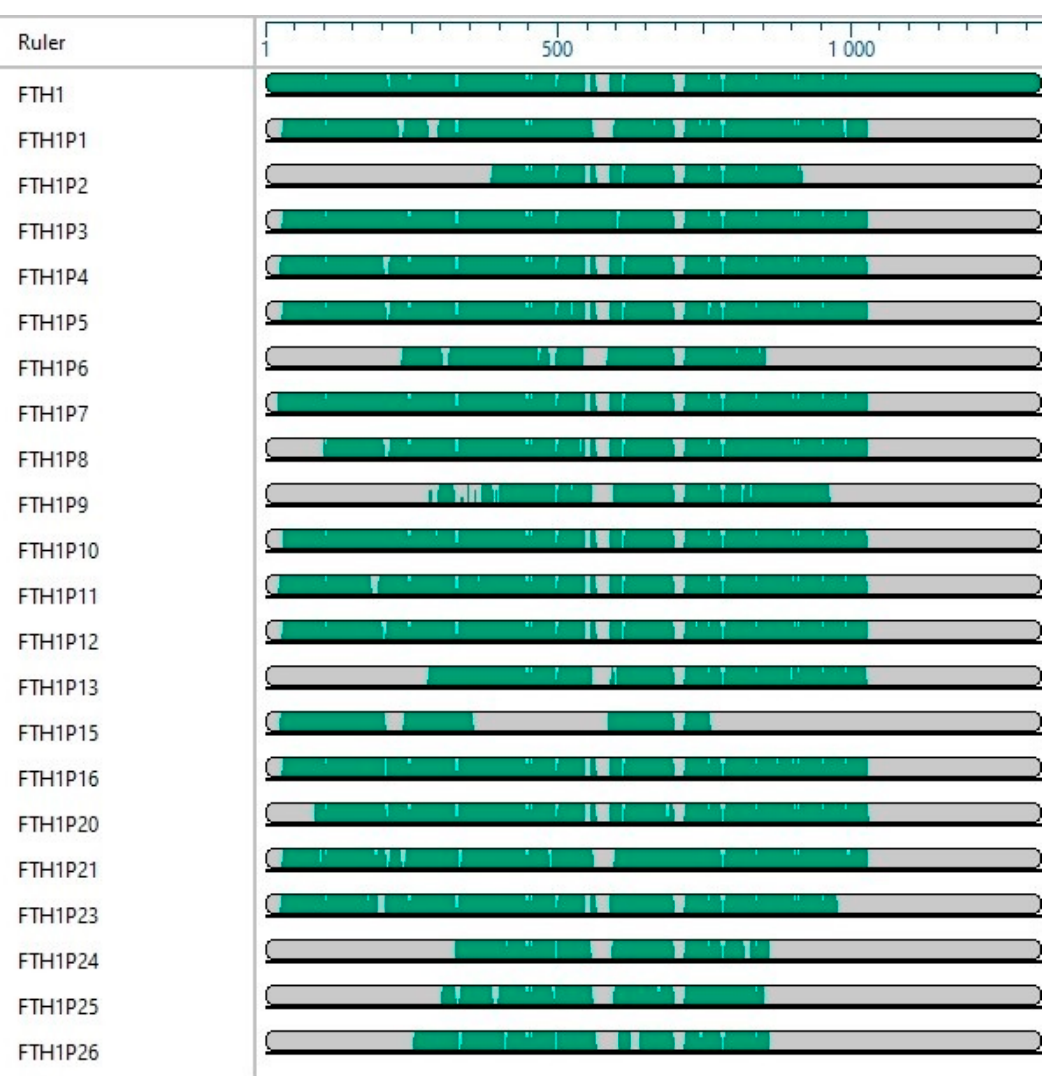
Figure 2. Multiple sequence alignment of the FTH1 family using MegAlign Pro version DNA STAR, Inc.2020 [69]. In each “sequence block” the green areas representing regions of similarity between sequences while the gray areas representing gaps.